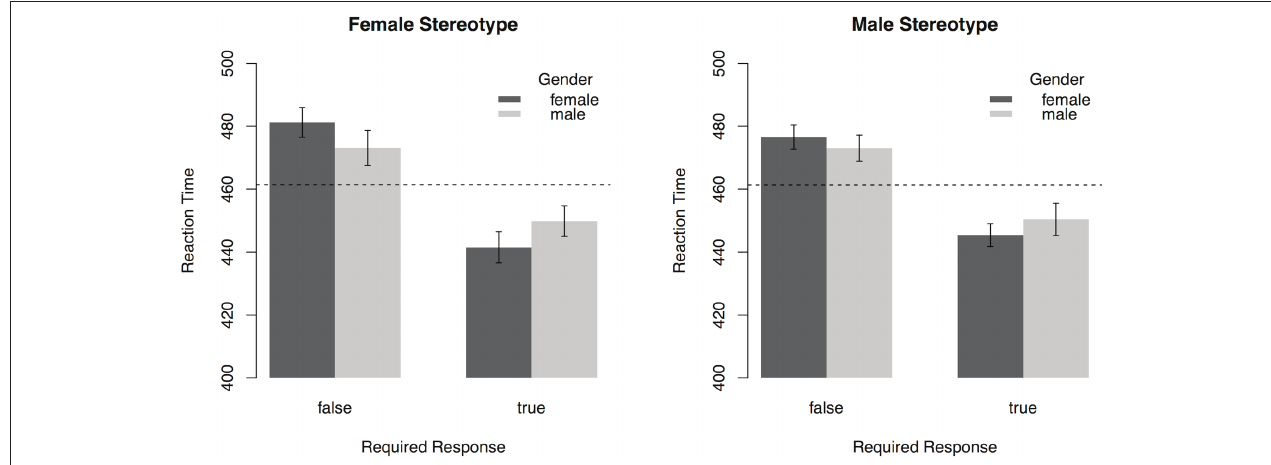
FIGURE 4 | Reaction times (error bars indicate 95% CI) in the PEP depending on Gender named in sentence, Required Response , and the type of Gender Stereotype (Experiment 3). Dashed lines represent mean reaction time. On the sample level, there is no indication that participants associate men (women) more with gender congruent male (female)